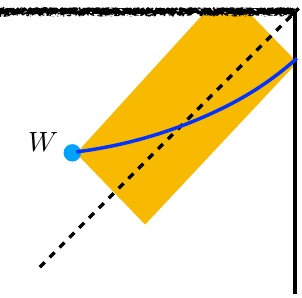
Figure 1 . In order to reconstruct an operator at W, we need to use the circuit stored between W and the